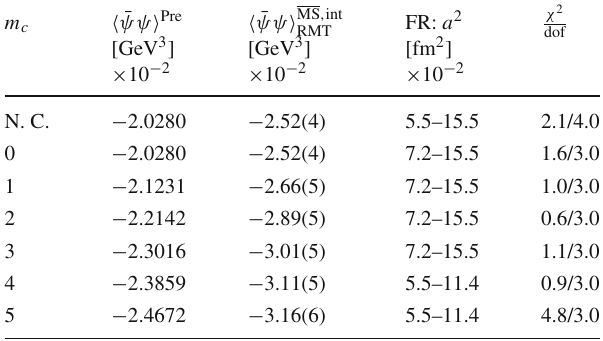
Table 11 Comparing the prediction (cid:5) ¯ ψψ (cid:6) Pre with the interpolated at the continuum limit, and their fitting results (cid:5) ¯ ψψ (cid:6) MS , int RMT